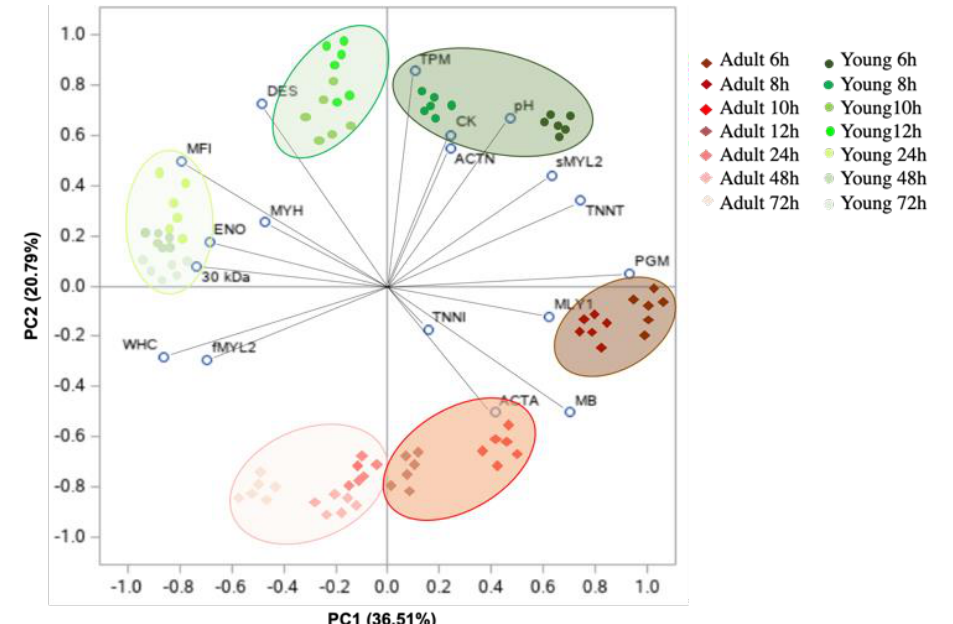
Figure 6. Principal component analysis (PCA) of the pH, MFI, WHC and relative intensity of the myofibrillar and sarcoplasmic proteins of the longissimus lumborum muscles from young and adult dromedaries during postmortem time (6, 8, 10, 12, 24, 48 and 72 h).